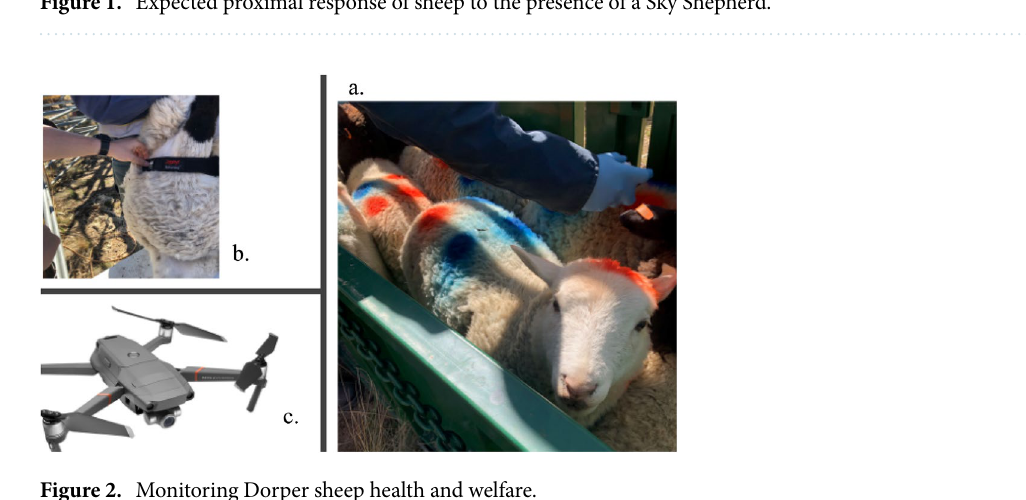
Figure 2. Monitoring Dorper sheep health and